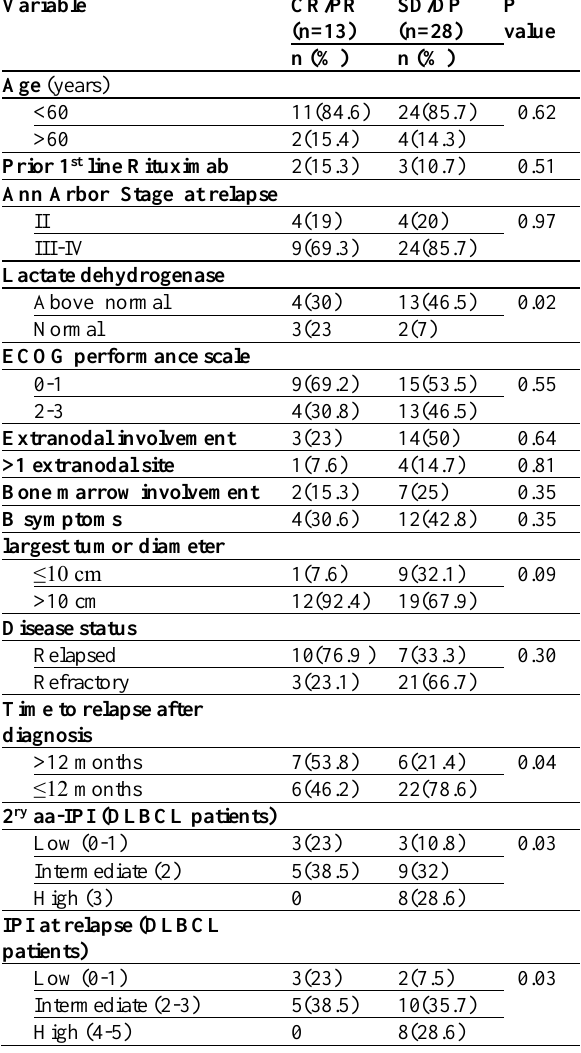
Table 3. Univariate analysis for factors affecting